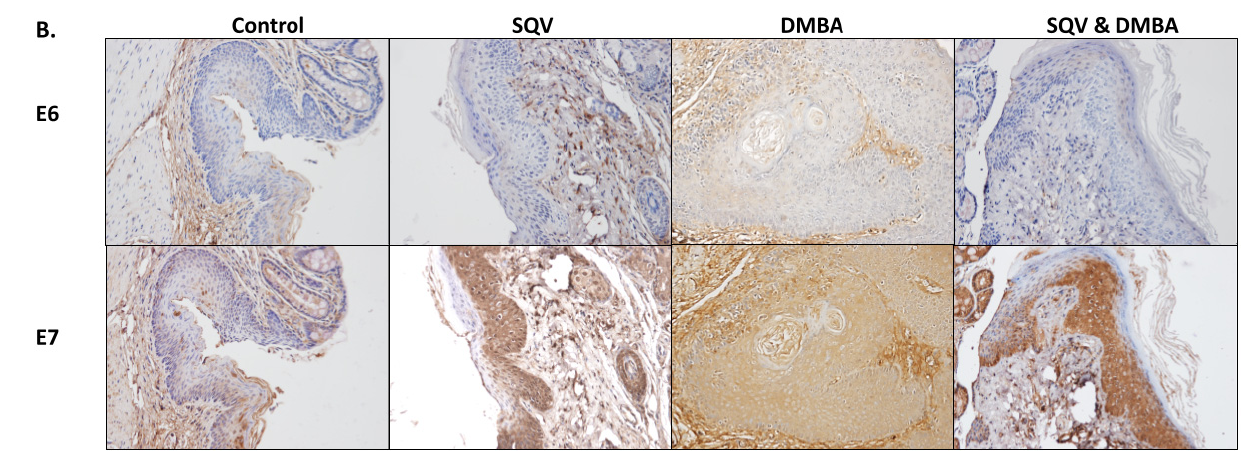
Figure 4. Expression of viral E6 and E7 oncoproteins: ( A ) Quantification of E6 and E7 expression in each treatment group. Significance was assessed as * p < 0.05, “ns” is not significant. ( B ) Representative images of immunohistochemically stained anal tissue from mice in each treatment group for E6 and E7.